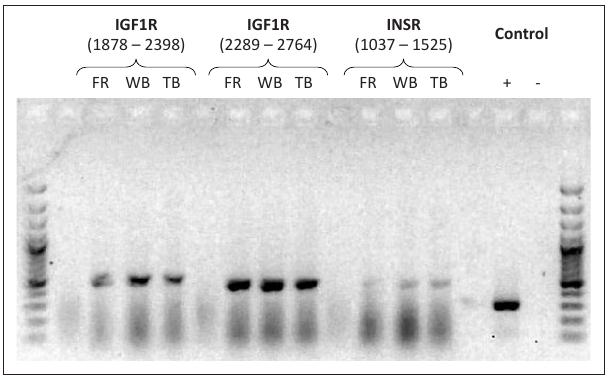
FIGURE 1: Bromide-stained 1.5 % agarose gel of IGF1R (520 and 453 bp) and INSR (488 bp) PCR products, with positive (300 bp) and negative RT-PCR controls and DNA ladders in first and last